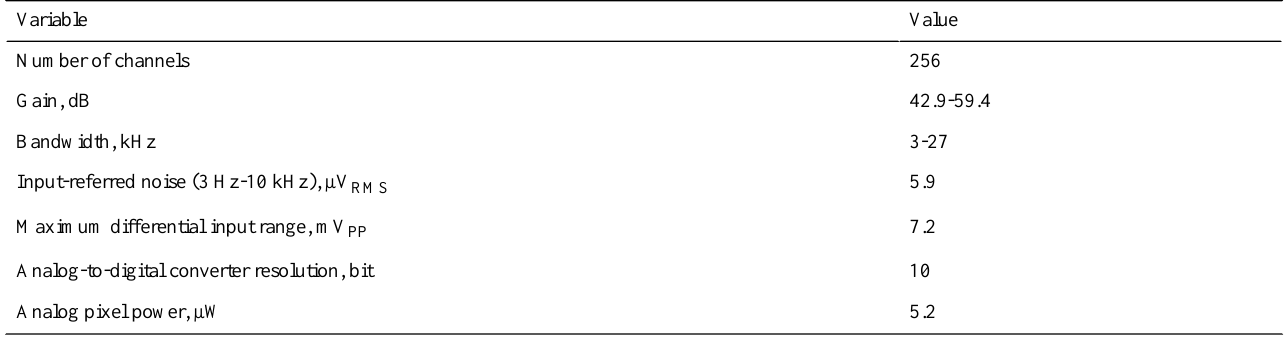
Table 1. Neuralink application-specific integrated circuit.